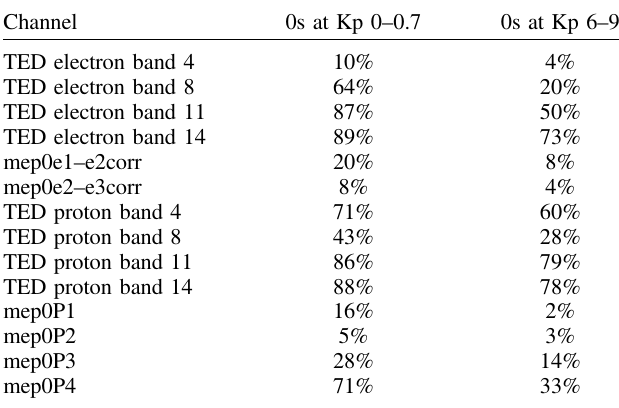
Table 2. Fraction of zero count rates in the central polar cap fl